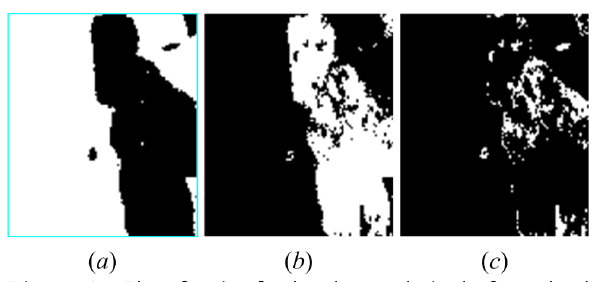
Figure 6. The fractional abundance derived from hard classification ( a ) water, ( b ) bare soil / deciduous tree and ( c ) evergreen tree